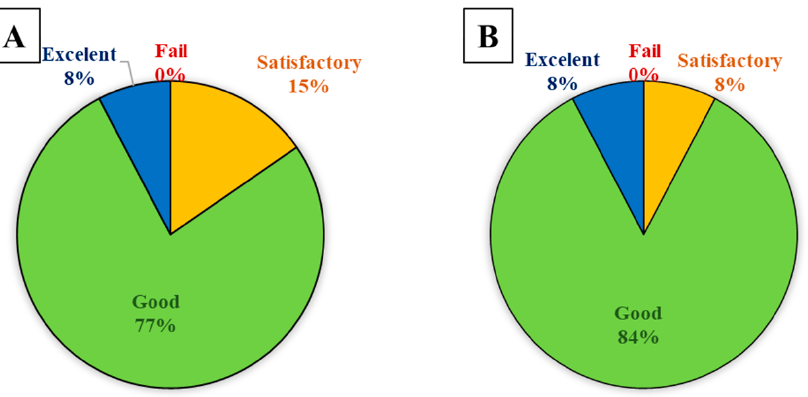
Figure 2. Percentage of students who obtained the indicated grade range. Fail (grade < 5), Satisfactory (5 ≤ grade < 7), Good (7 ≤ grade < 9), Excellent (grade ≥ 9). ( A ). Pre test, ( B ) Post test.